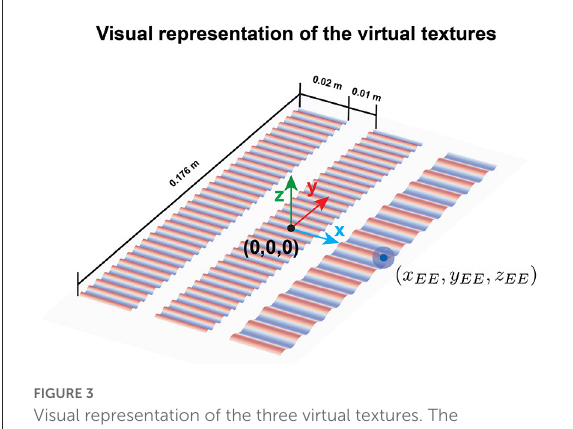
FIGURE3 Visual representation of the three virtual textures. The coordinate center of the workspace is denoted by (0,0,0) and was located in the center of the second texture. The robot end effector is depicted with a blue ball whose center had the coordinates ( x EE , y EE , z EE ). The scale and size of the textures and the ball are only for visual purposes and do not represent the scale and size used in the